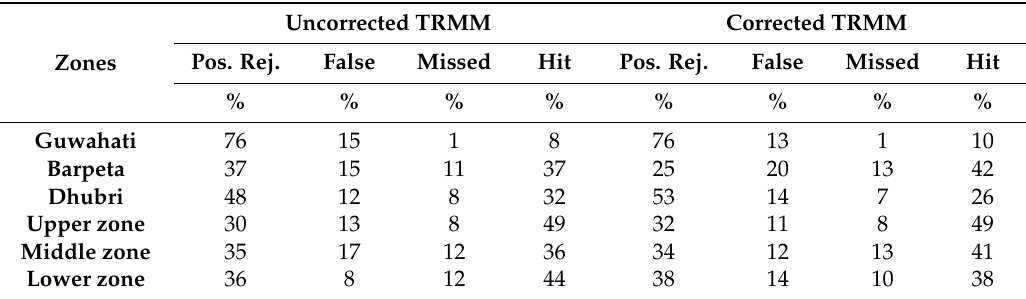
Table 5. Contingency table for the flood event of 29-06-2012. The numbers show the percentage of pixels of inundation maps falling into the four groups positive rejection, false alarm, missed alarm and hits for the six chosen geographic